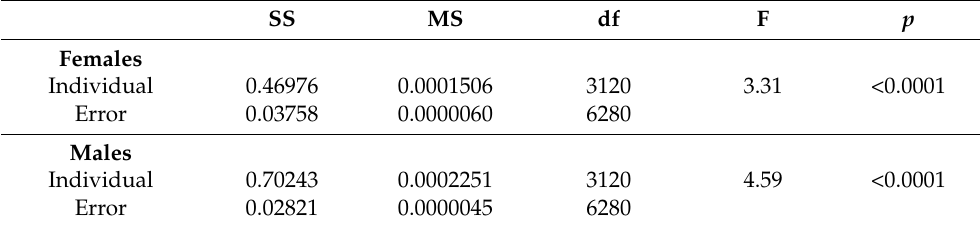
Table 3. Procrustes ANOVA of shape in Acanthoscelides obtectus females and males with effects of